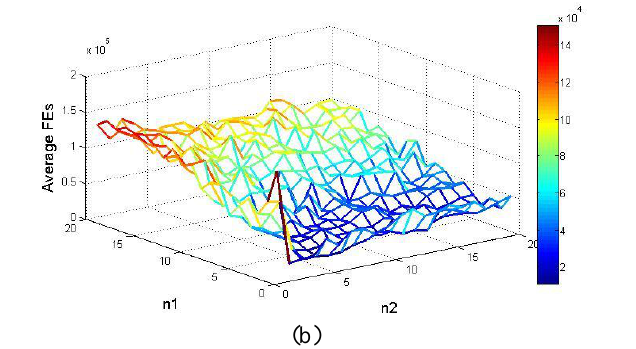
Fig. 6 The Effect of Alternative Group Sizes on Optimization Schaffer 1 Problem (SF1) of 2- dimension (a) Result of Success Rate, (b) Result of Average Function Evaluations